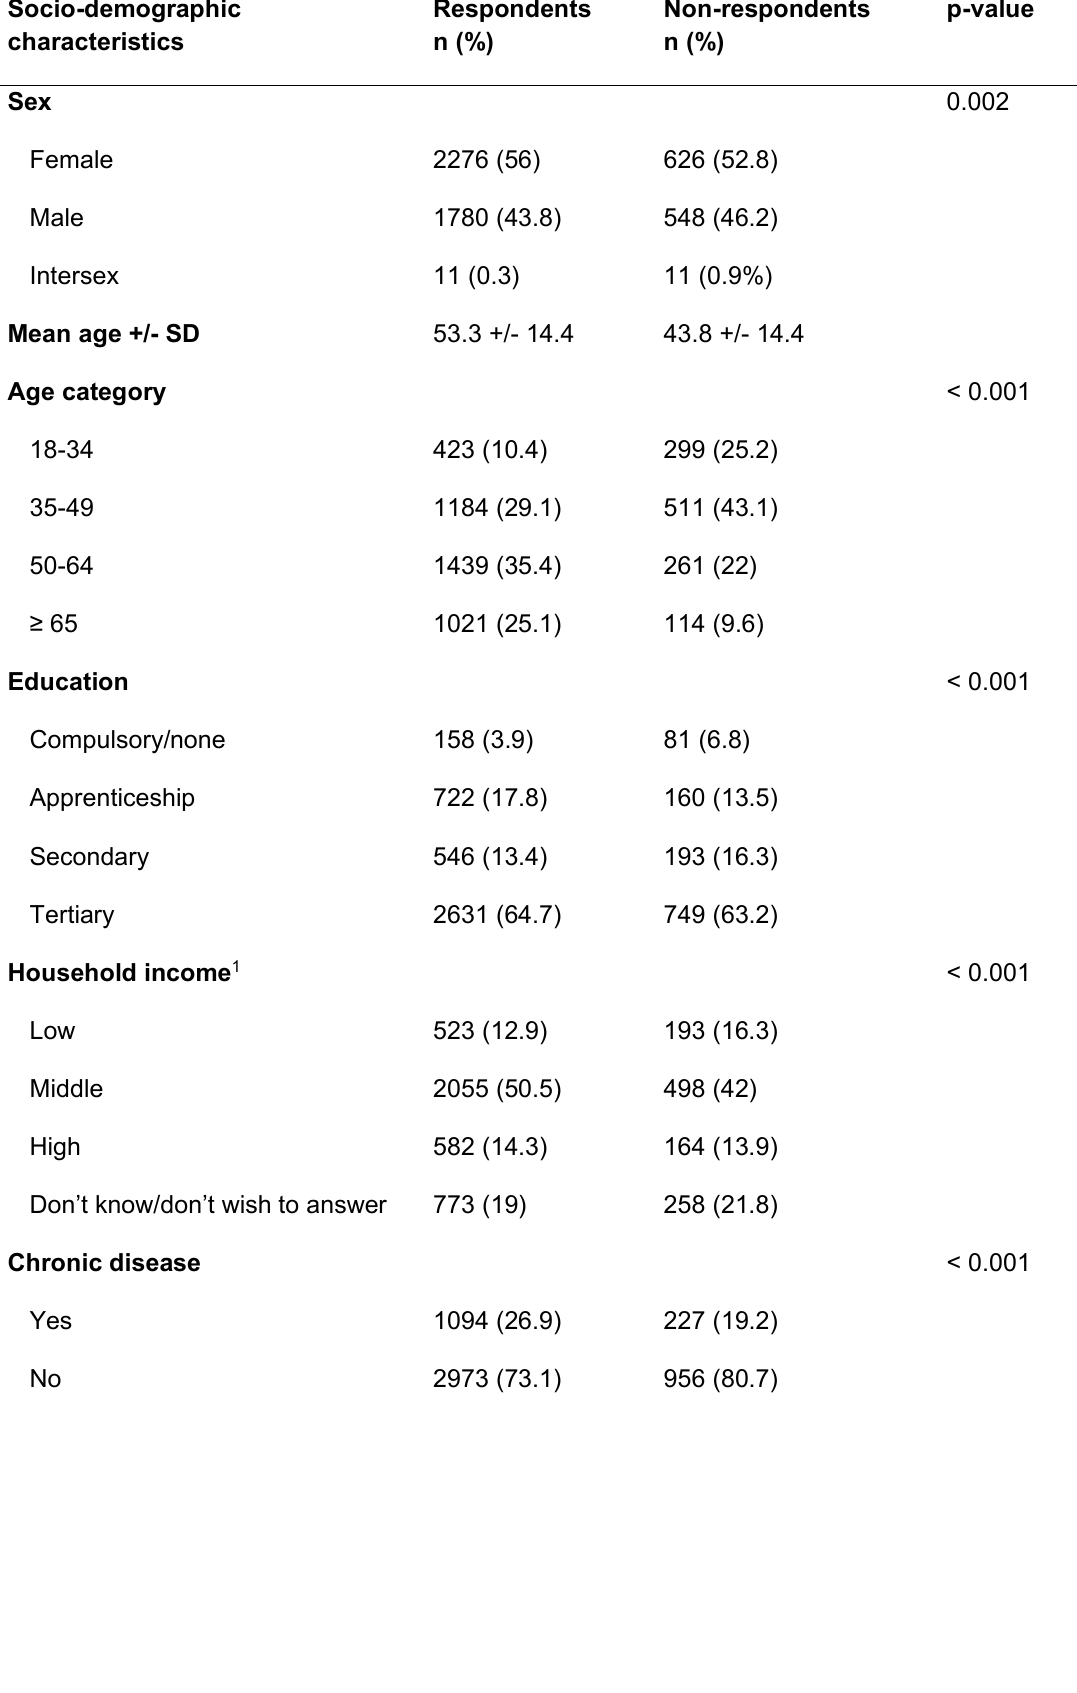
Table S1 Socio-demographic and health-related characteristics of respondents (n=4’067) vs. non- respondents (n=1’185) to the vaccination